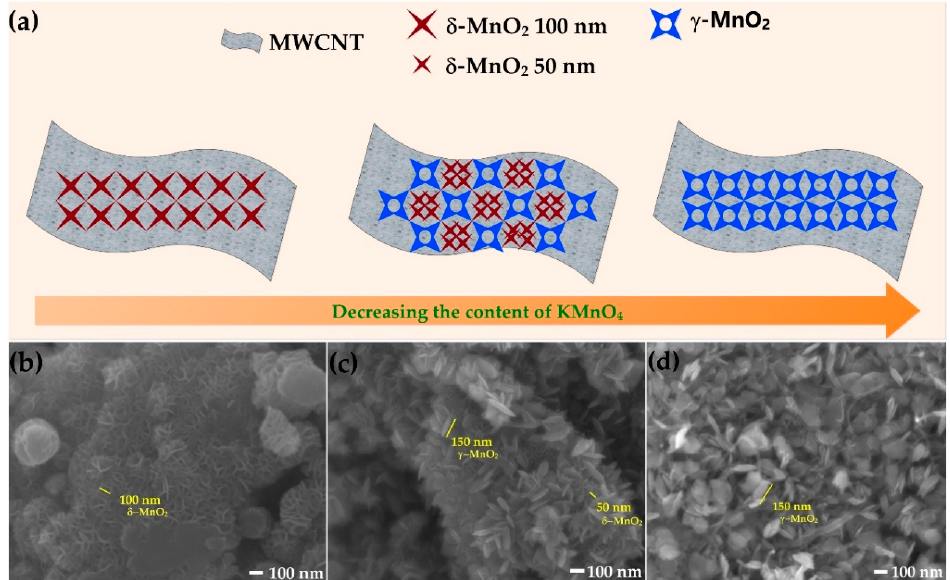
Figure 2. Morphological schema: ( a ) Schema of changes in morphology of MN-CNT followed by decreasing the content of KMnO 4 ; ( b ) FESEM image of MN-CNT9010; ( c ) FESEM image of MN-CNT7525 and ( d ) FESEM image of MN-CNT6040.